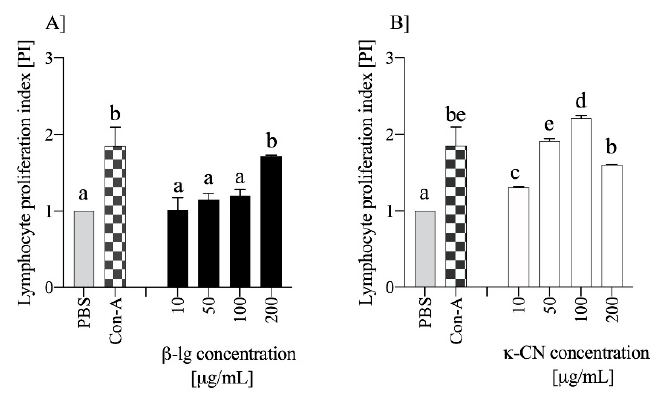
Figure 2. The effect of antigen dose on proliferation index (PI) of naïve splenocytes stimulated with different doses of β -lg ( A ) or κ -CN ( B ) after 120 h culture. Cells were obtained from non-immunized mice. PI was determined with MTT method and calculated as the ratio of mean absorbance of antigen stimulated cells to mean absorbance of unstimulated cells. Concanavalin A (Con-A) was used as a positive control. The data are presented as the means ± SD. Statistical analysis was performed with one-way ANOVA followed by post hoc Tukey test. Different letters present statistical differences between means at p ≤